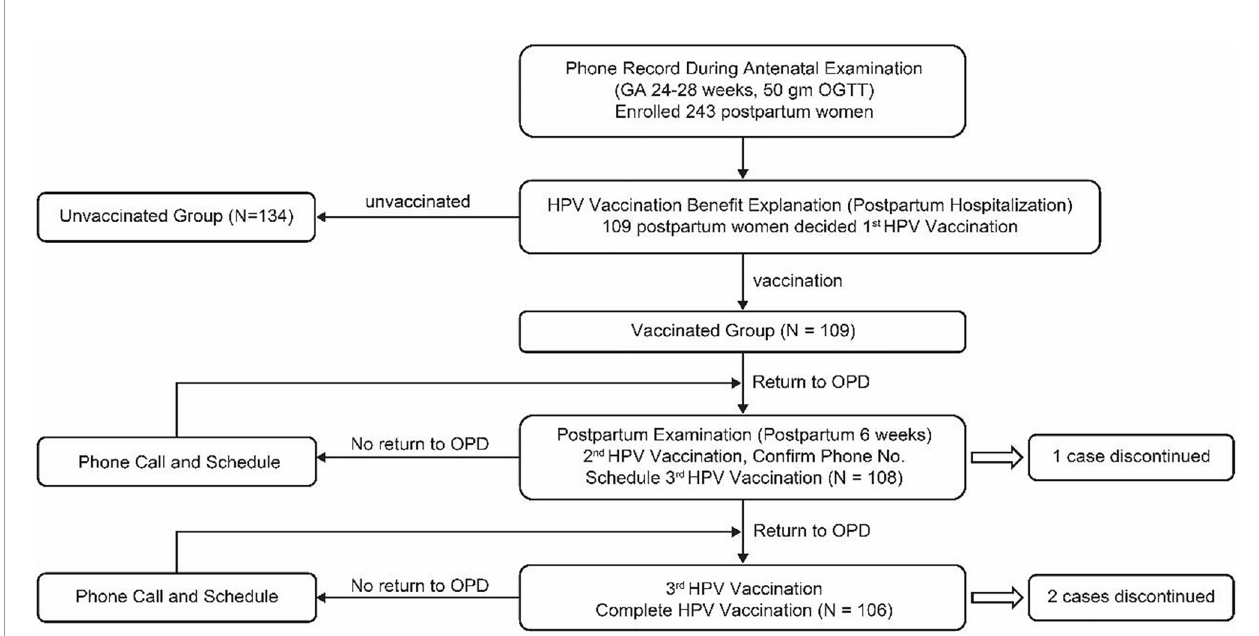
FIGURE 1 | Flow chart of subjects in the controlled postpartum HPV vaccination program. GA, gestational age; OGTT, oral glucose tolerance test; HPV, human papillomavirus; OPD, outpatient